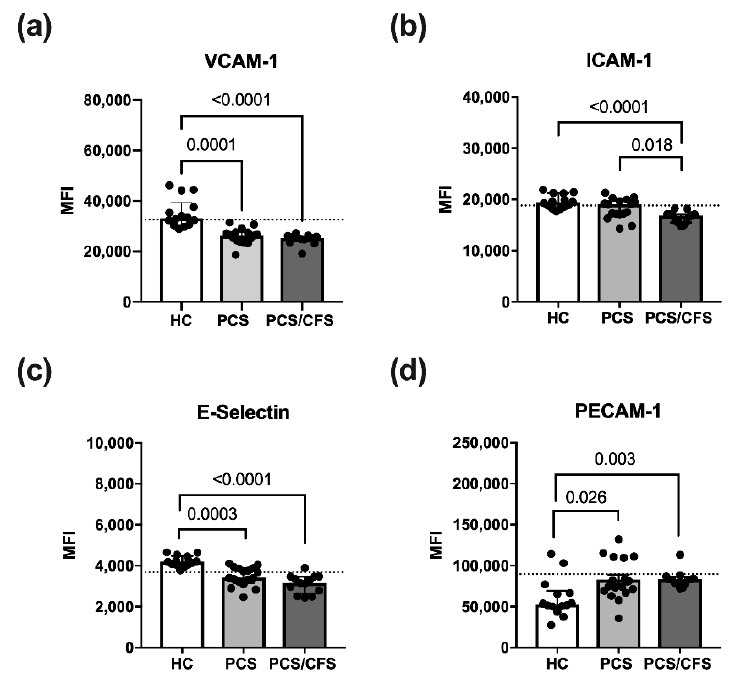
Figure 2. Endothelial cell activation surface marker expression following serum incubation. Ex- pression levels of selected surface markers on HUVECs assessed by flow cytometry. Briefly, cultured cells were treated with 2% ( v / v ) patient (PCS, PCS/CFS) or control (HC) serum for 6 h before harvest and staining for flow cytometry. Examined are surface markers indicative for endothelial cell activation VCAM-1 ( a ), ICAM-1 ( b ), E-Selectin ( c ) and PECAM-1 ( d ). The expression levels are shown as mean fluorescence intensities (MFI). Dotted lines denote baseline marker expression level of untreated HUVECs. Statistical significance was determined using a Kruska-Wallis test. A p value ≤ 0.05 was considered significant. HC, healthy controls (n = 14). PCS, post-COVID-19 syndrome (n = 17). PCS/CFS, post-COVID-19 syndrome with ME/CFS (n = 13).